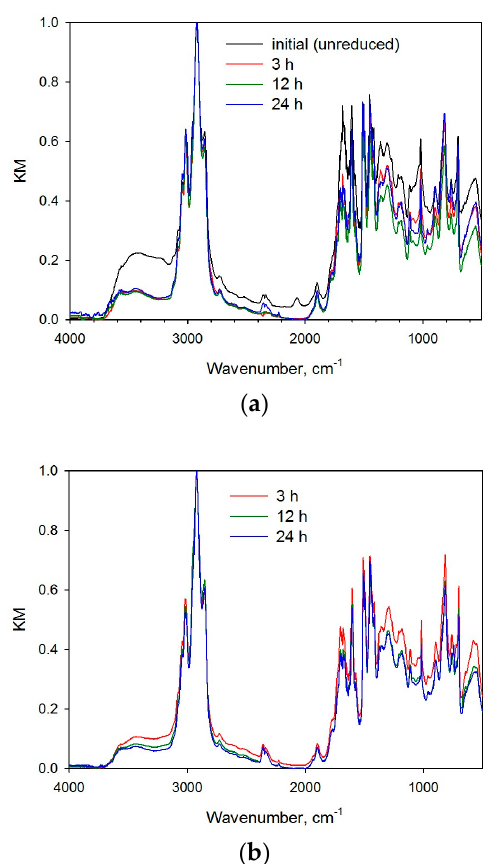
Figure 7. Normalized IR-spectra of Pt-HAP (unreduced (black line) and reduced for 3 h (red line), 12 h (green line) and 24 h (blue line)) ( a ) and of the three preliminarily reduced samples taken after the NL hydrogenation ( b ).